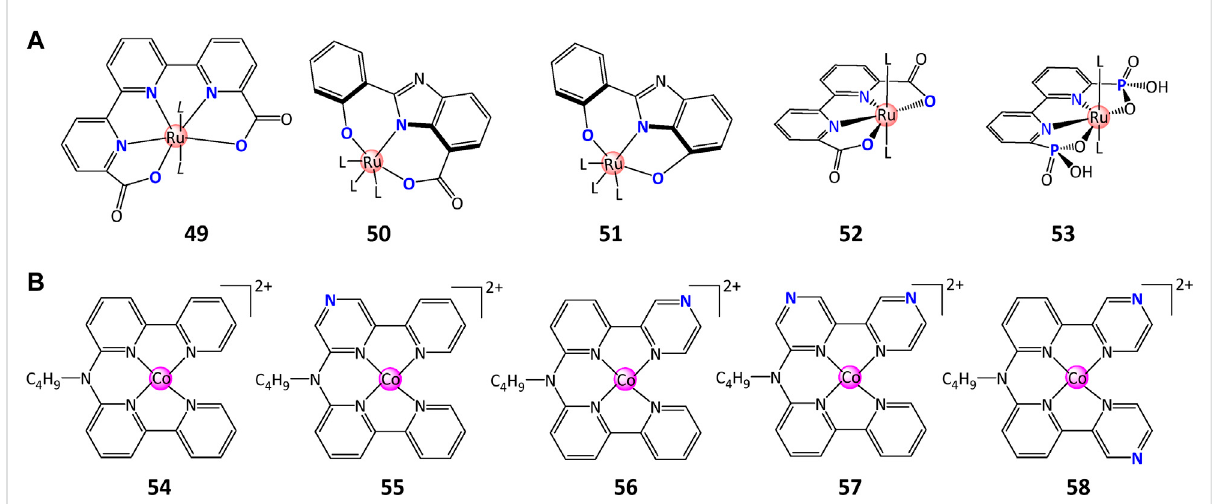
FIGURE 20 Chemical structures of (A) complexes containing ligand carboxylates, and (B) various cobalt molecular catalysts with different number and position of nitrogen in